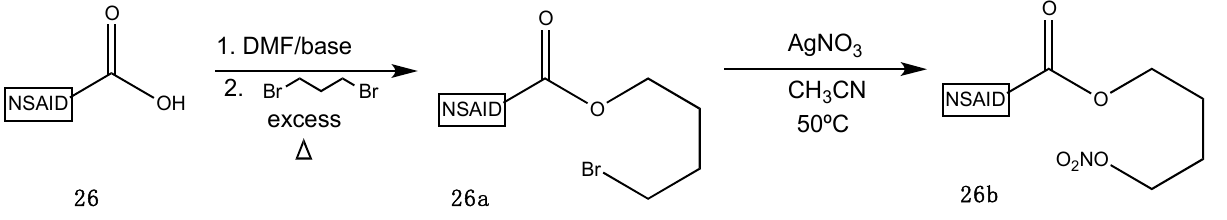
Figure 12. Synthetic pathway for ·NO donor NSAIDs.